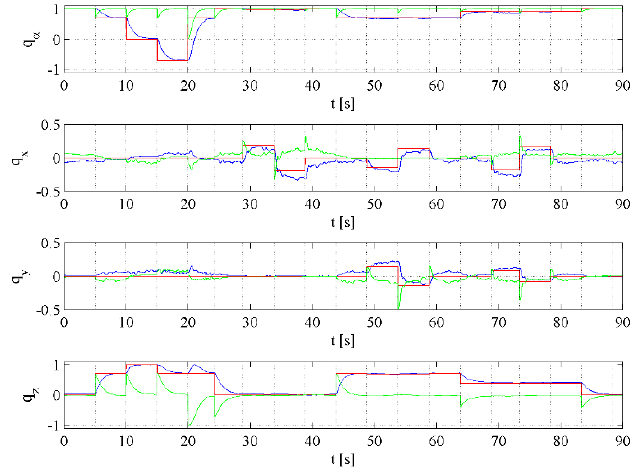
Figure 14. Performance of the sequence using the LQR (Linear Quadratic Regulator) controller expressed by various quaternions, such as actual quaternion (blue line), quaternion error (green line) and desired quaternion (red line).